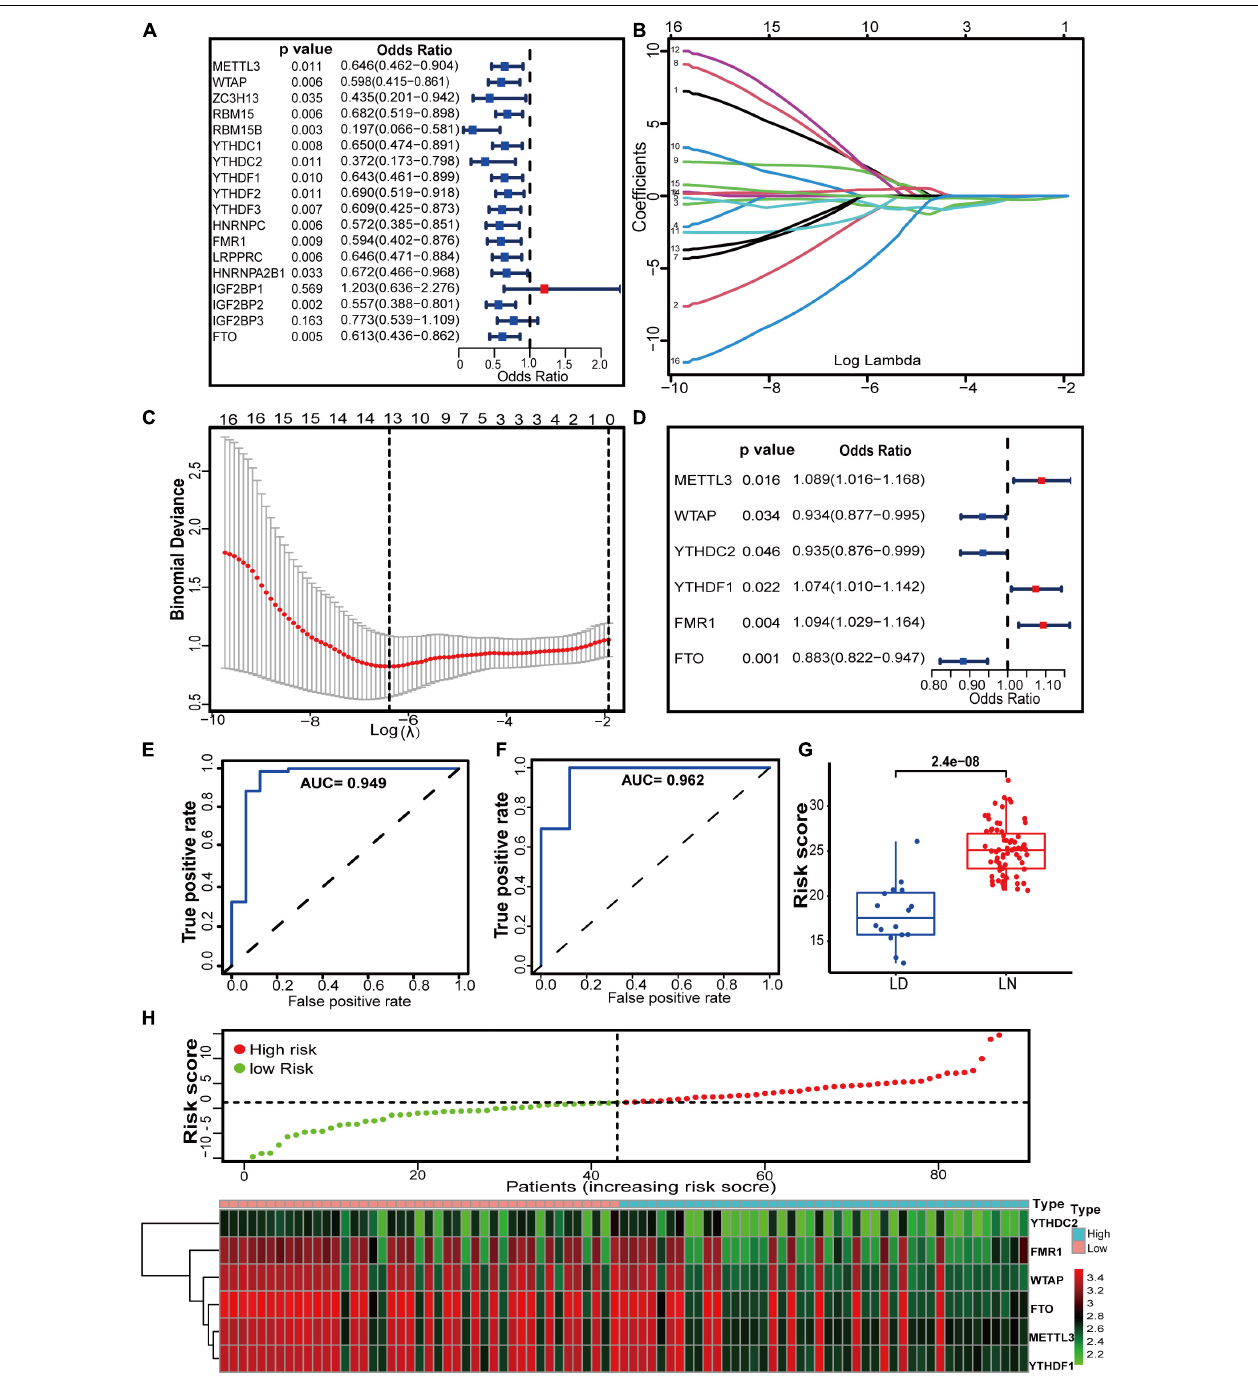
FIGURE 3 | m 6 A regulators have the potential to distinguish between healthy and LN individuals. (A) Univariate logistic regression revealed 16 LN-related m 6 A regulators ( P < 0.05). (B,C) Feature selection by LASSO regression model. (B) By verifying the optimal parameter (lambda) in the LASSO model, the partial likelihood deviance (binomial deviance) curve was plotted vs. log (lambda). Dotted vertical lines were drawn based on 1 SE of the minimum criteria (the 1-SE criteria). (C) Thirteen features with non-zero coefficients were selected by optimal lambda. A coefficient profile plot was produced against the log (lambda) sequence in (B) . (D) Multivariate logistic analysis distinguished six independent risk factors and risk scores for LN were calculated using the LASSO Logistic regression algorithm. (E,F) The predictive value of the m 6 A regulator gene signature in the derivation (E) and validation (F) sets by calculating the pooled AUC. 0.9 < AUC ≤ 1 indicates that the gene signature has high accuracy. (G) Distribution of risk scores in healthy and LN samples. (H) Risk score distribution based on the 6 m 6 A RNA modification regulator signature and gene expression profiles between our study groups. Patients were divided into high-risk and low-risk groups by the black dotted line, which indicates the median cut-off